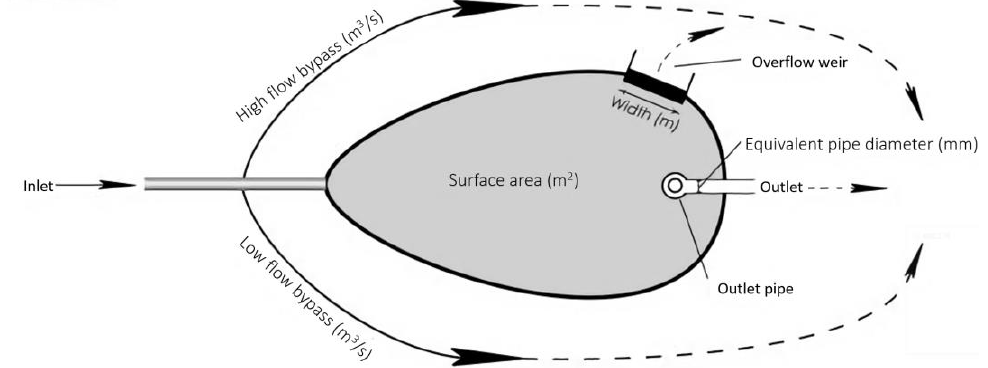
Figure A2. The schematic diagram of pond [112].